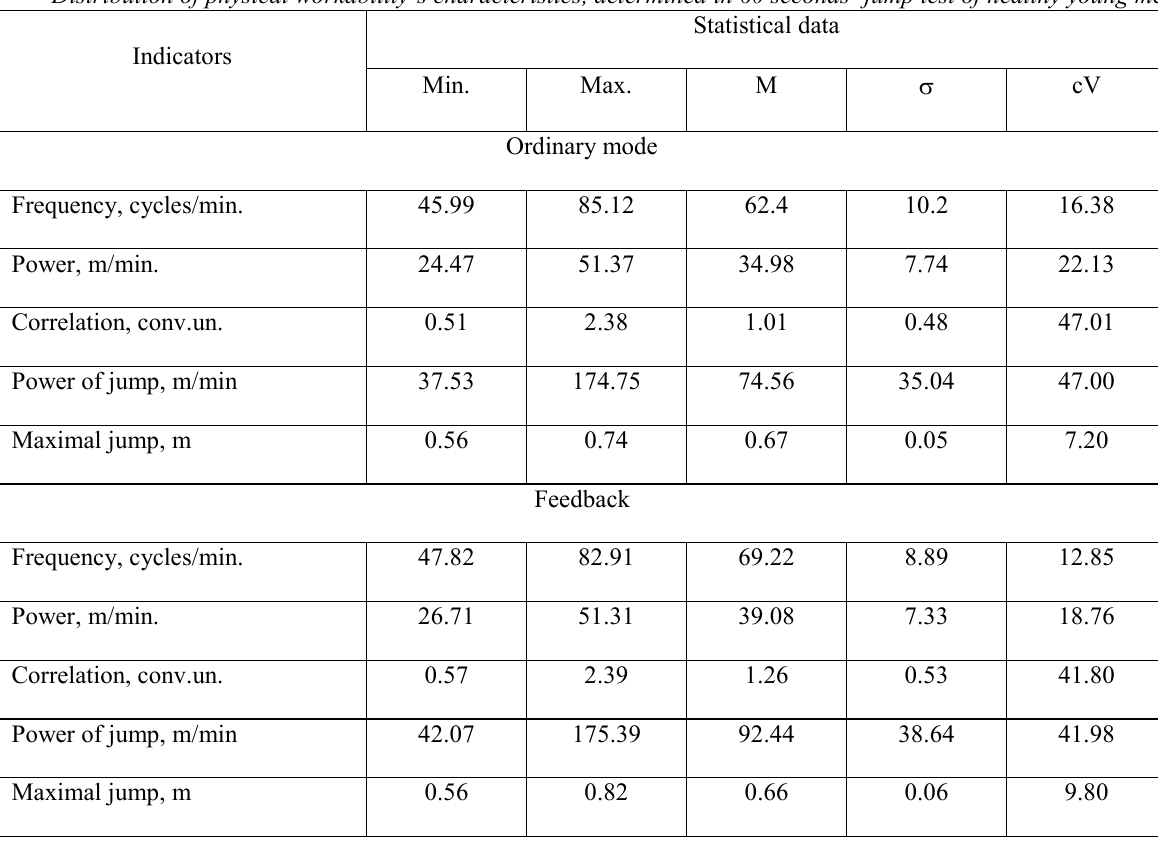
Frequency, cycles/min. Power, m/min. Correlation,